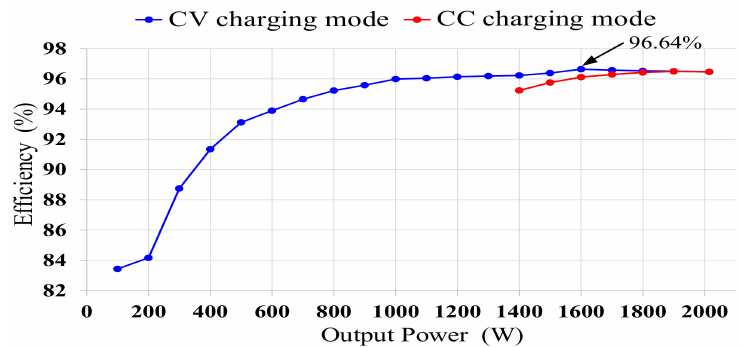
Figure 19. CC–CV charging efficiency curve of the fabricated converter.